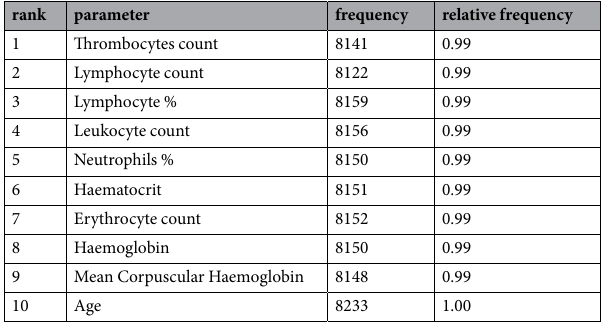
Table 3. Ten most important blood parameters and their frequencies. It is interesting to note that all these parameters are present in almost all